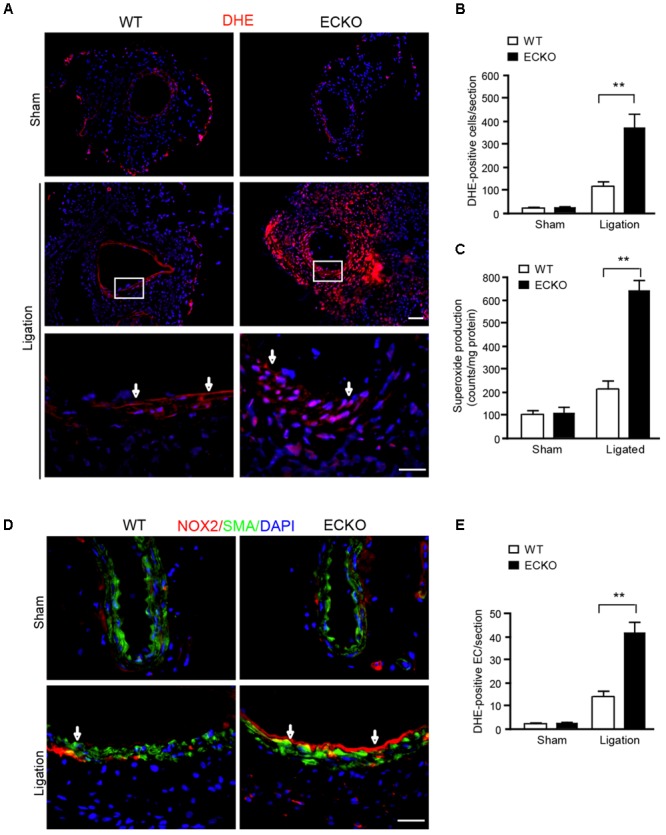
AIP1 deletion enhances NOX2 activity and ROS generation in EC and infiltrated cells. (A,B) At day 3 post-ligation, tissue oxidative stress in common carotid arteries was determined by an in situ detection of superoxide with dihydroethedium (DHE) fluorescence. Representative images are shown in (A) with high power images for the boxed area. DHE positive cells/section is quantified in (B). (C) Total NOX activity in carotid artery was determined by lucigenin assay. Data are presented are mean ± SEM, with n = 6 animals. ∗∗P < 0.01. (D,E) NOX2 was detected by immunofluorescence staining with anti-NOX2. Smooth muscle actin staining was used to visualize media. Representative images are shown in (D) with high power images for the boxed area. NOX2 positive EC/section and DHE positive cells/section are quantified in (E). Arrows indicate positive staining in endothelium. Data are presented are mean ± SEM, with n = 6 animals and 4 sections per artery. ∗∗P < 0.01. Scale bar: 50 μm (A,D).